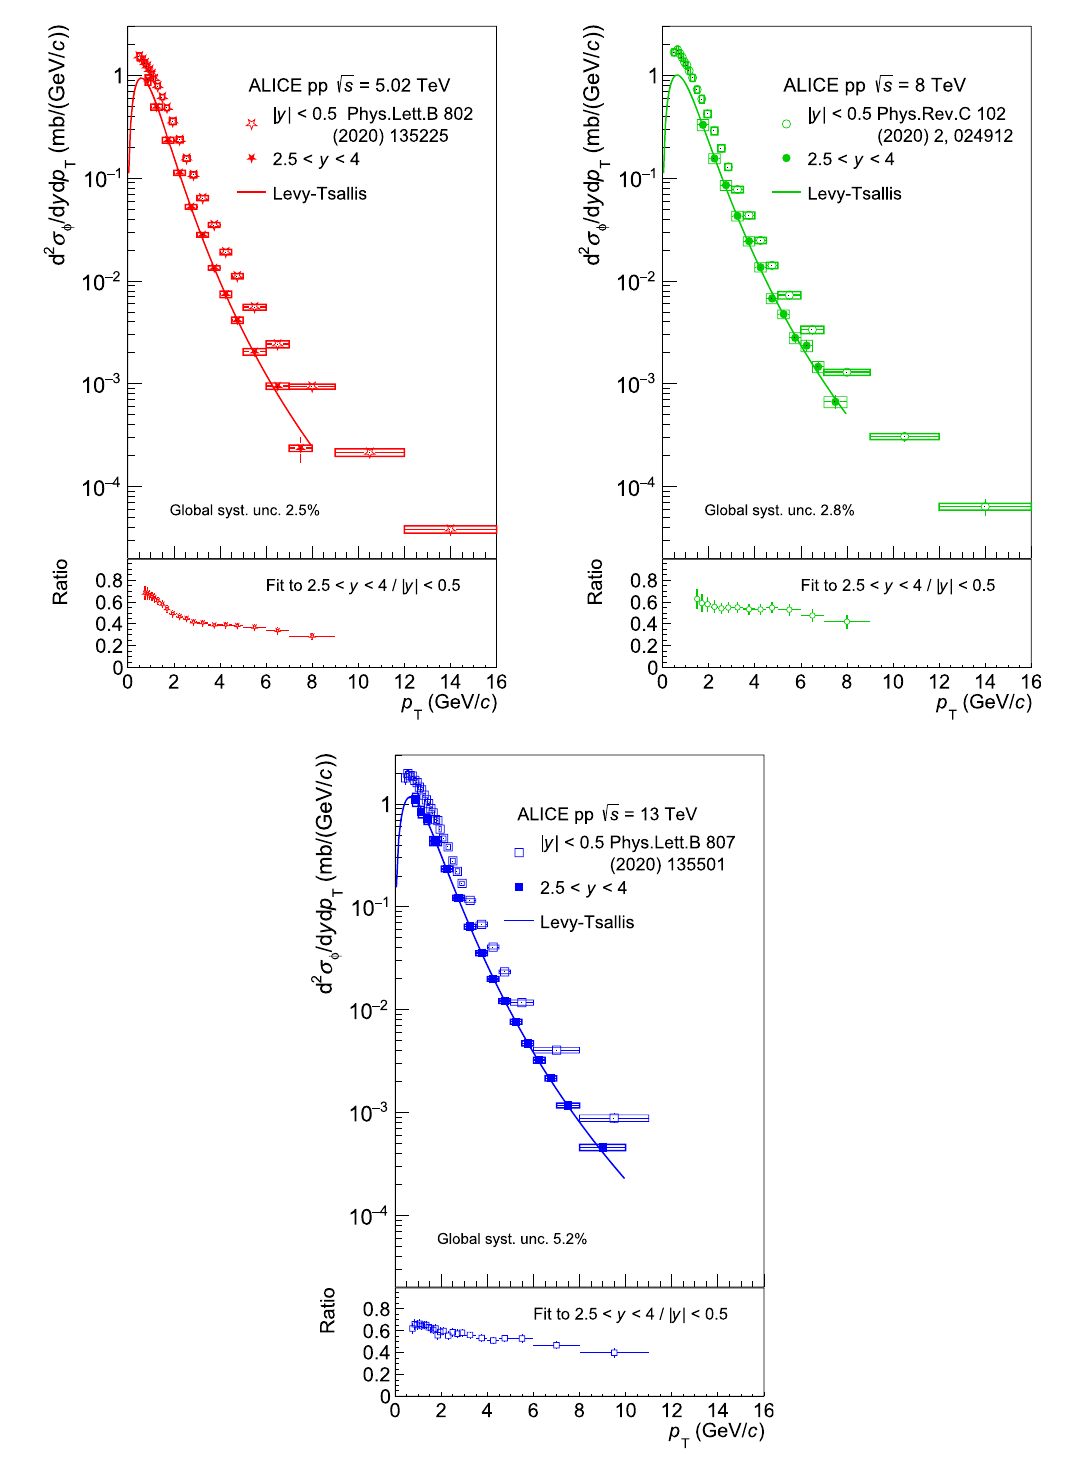
Fig. 2 Differential φ meson production cross section d 2 σ/( d y d p T ) as symbols). The boxes represent the systematic uncertainties, the error √ √ √ s = 5 . 02 TeV, s = 8 TeV and s = 13 TeV, a function of p T at bars the statistical uncertainties. The data points are fitted with a Levy– measured in the μ + μ − decay channel in the rapidity interval 2 . 5 < Tsallis function. The ratio between the fit function at forward rapidity y < 4 (full symbols) and in the K + K − channel at midrapidity (open and the data at midrapidity is plotted in the bottom